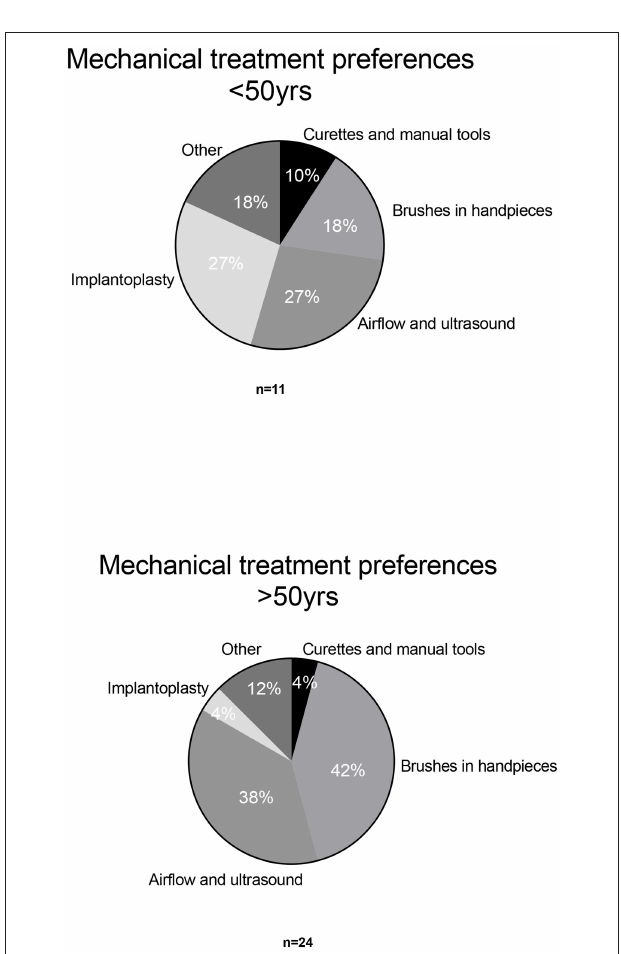
FIGURE 5 | Mechanical treatment preferences segmented by responder’s age.